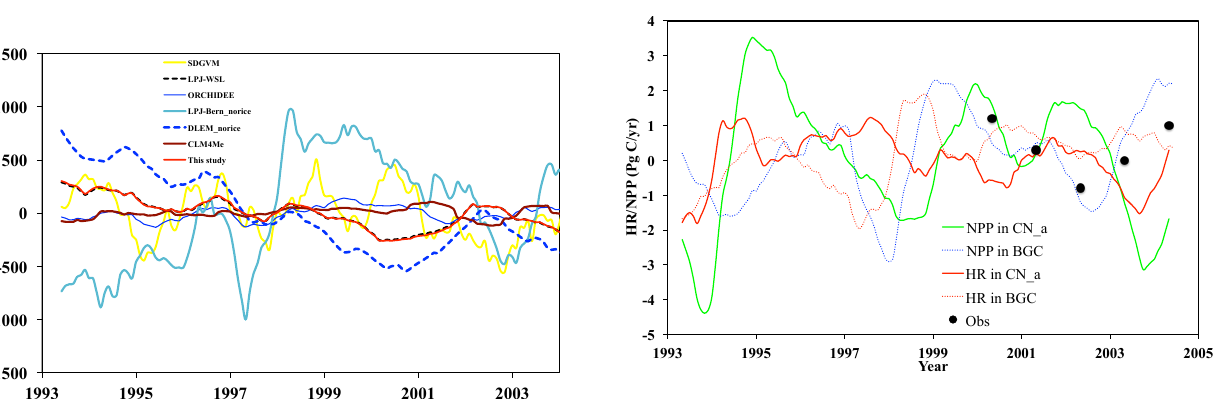
Figure 19. Temporal variation of the anomalies in globally averaged heterotrophic respiration (HR) and net primary production (NPP) in CN_a and BGC experiments. Blue dots indicate globally aver- aged NPP anomalies from satellites obtained from Zhao and Run- ning (2010). A 12-month smoothing is applied to monthly anoma- lies in HR and